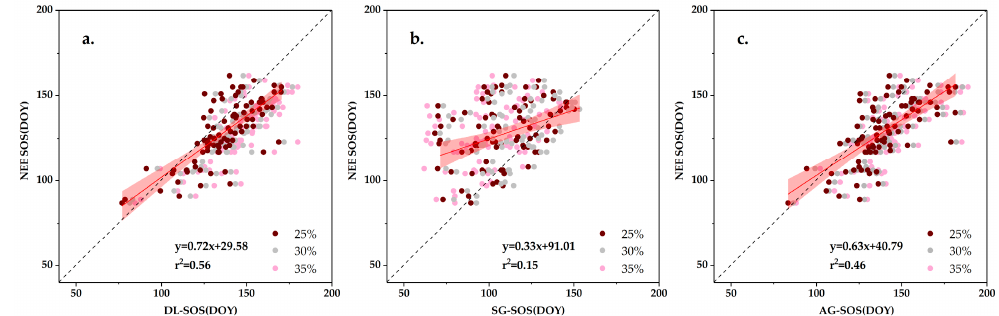
Figure 4. Verification of the results of different start of the season (SOS) extraction methods by NEE SOS: ( a ) Double logistic, ( b ) Savitzky–Golay and ( c ) asymmetric Gaussian. Bands indicate 95% confidence interval.